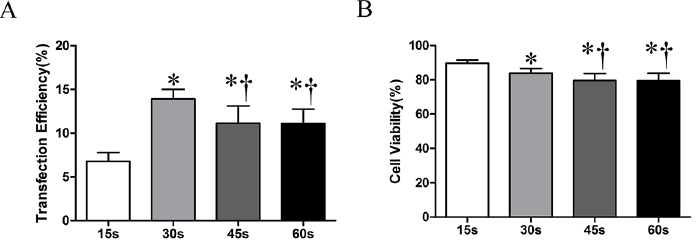
Fig 3. The effect of ET on cell transfection efficiency and cell viability. (A): transfection efficiency at different exposure time; (B): cell viability at different exposure time. Indication: Symbols indicate significant differences ( P < 0.05) from ET of 15 s ( * ) or 30 s ( † ).